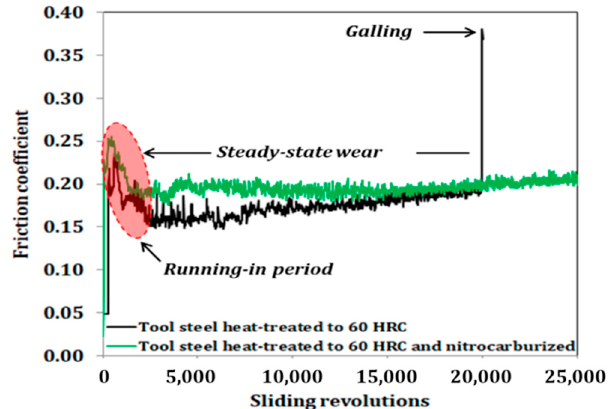
Figure 8. Evolution of the friction coefficient of a tool steel grade with and without nitrocarburizing surface treatment.